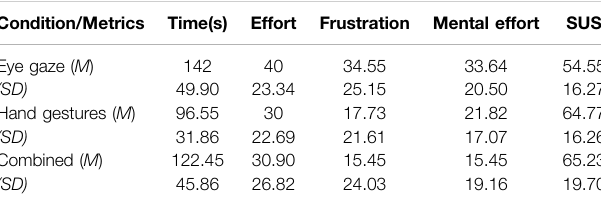
Frontiers in Virtual Reality |